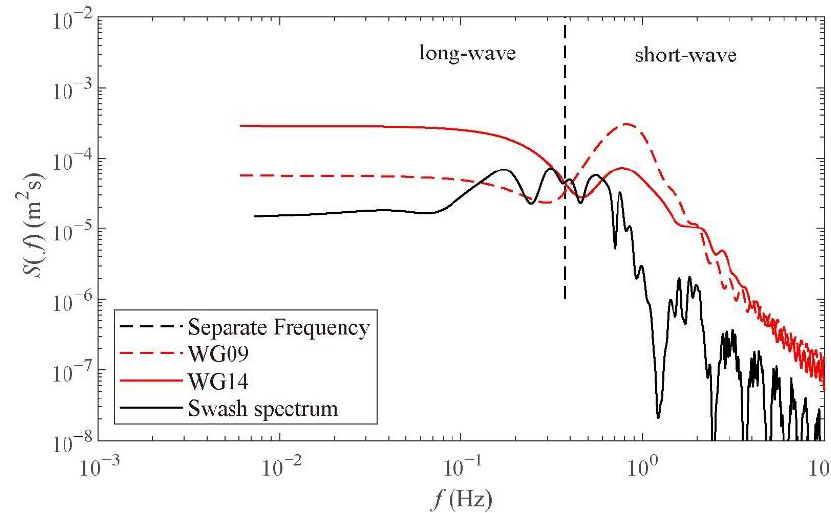
Figure 6. Wave spectrum evolution of experiment case T00B. The black dash line is the separation frequency of short wave and long wave. WG09 (red dash line) is located before wave breaking and WG14 (red solid line) is located nearshore.